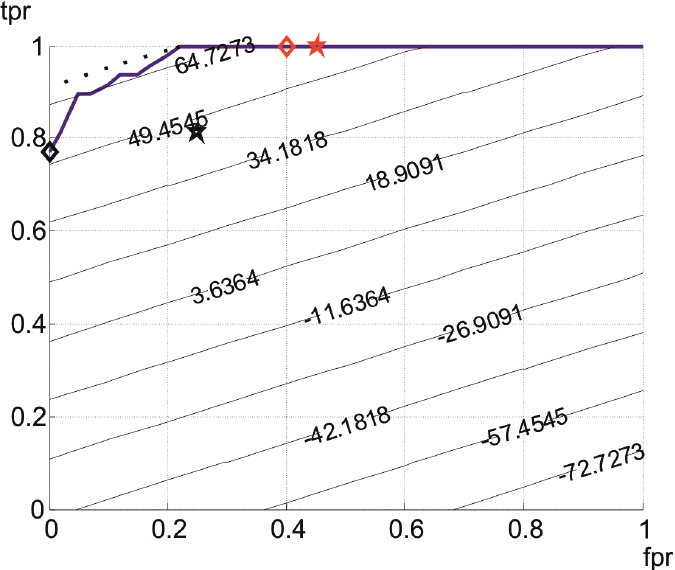
Figure 8. Enveloping curve of ROC points, associated with impact detection in the anisotropic algorithm for the personalized laboratory study. Isolines of F are presented to complete the comparison with Figure